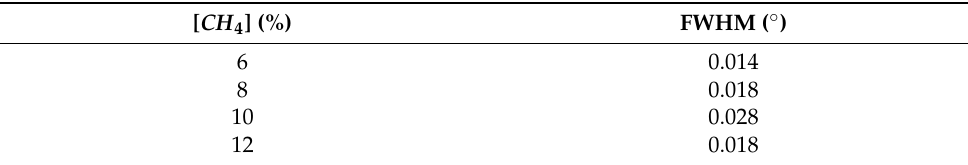
Figure 8. HRXRD rocking curve ( ω scan) around the diamond (004) reflection of all samples. Table 4. FWHM of the samples.